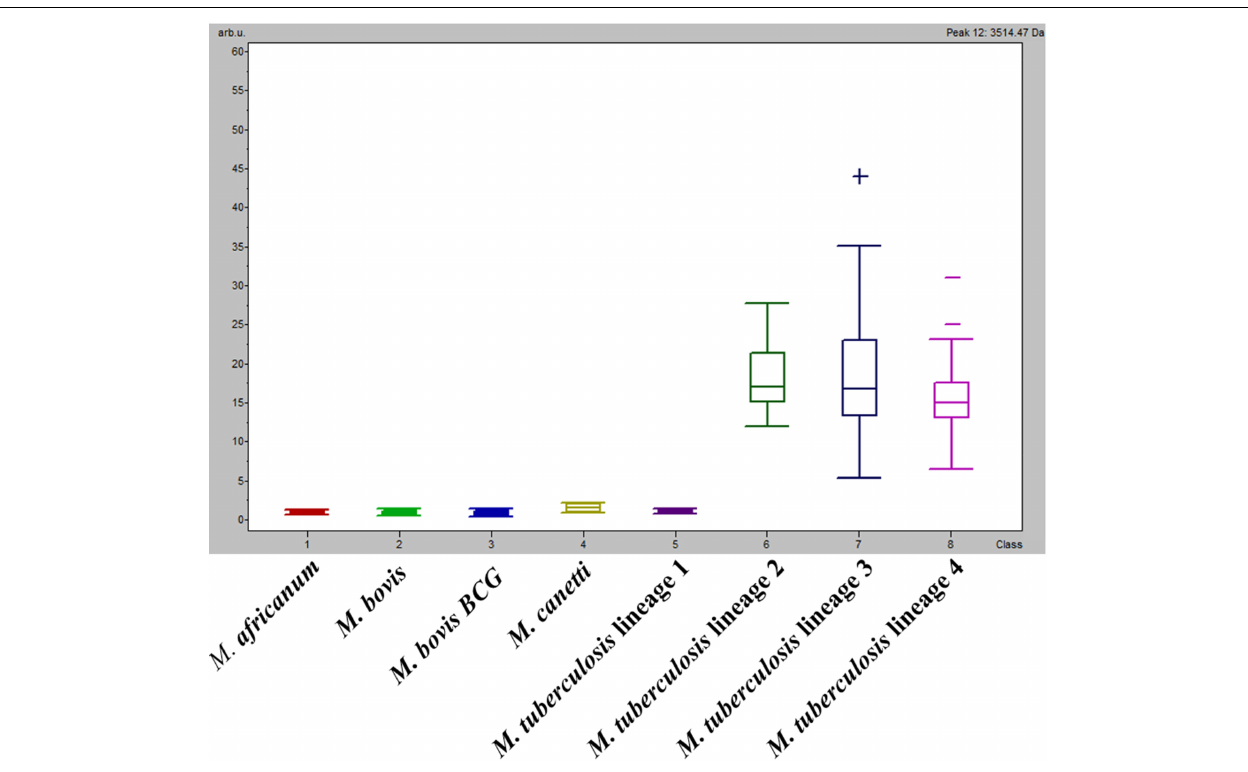
FIGURE 1 | Average intensities and variance (box plot) of m/z: 3,514 Da among classes.